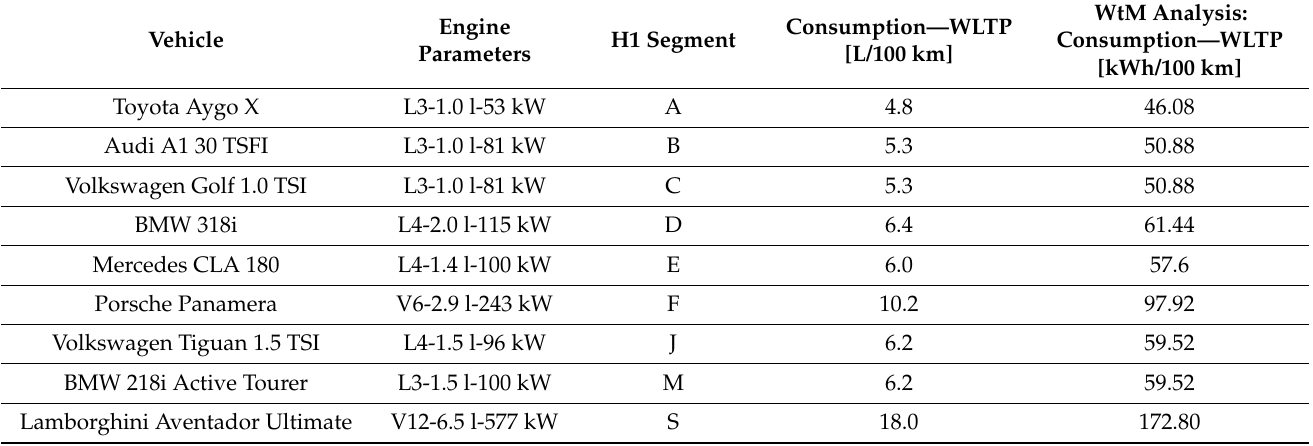
Table 6. Passenger vehicle fleet in Europe: division into powertrain and H1 segments—Powertrain: ICEV fed by gasoline